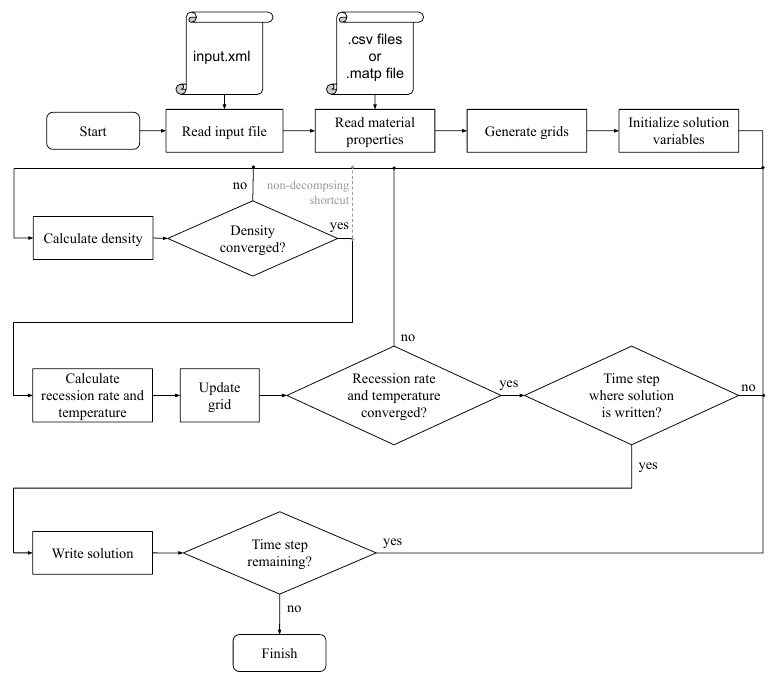
Figure 5. Flowchart of the developed FVM solver. The dashed line indicates a shortcut for the non-decomposing